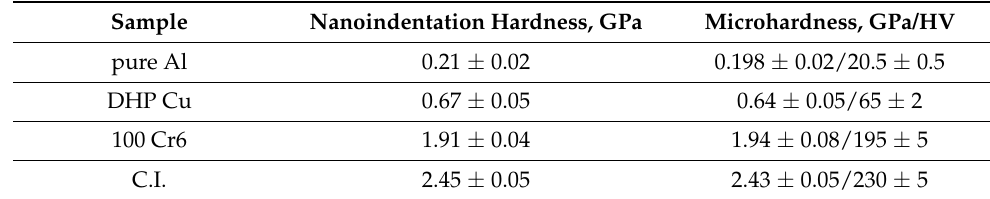
Table 1. Average vales of hardness and